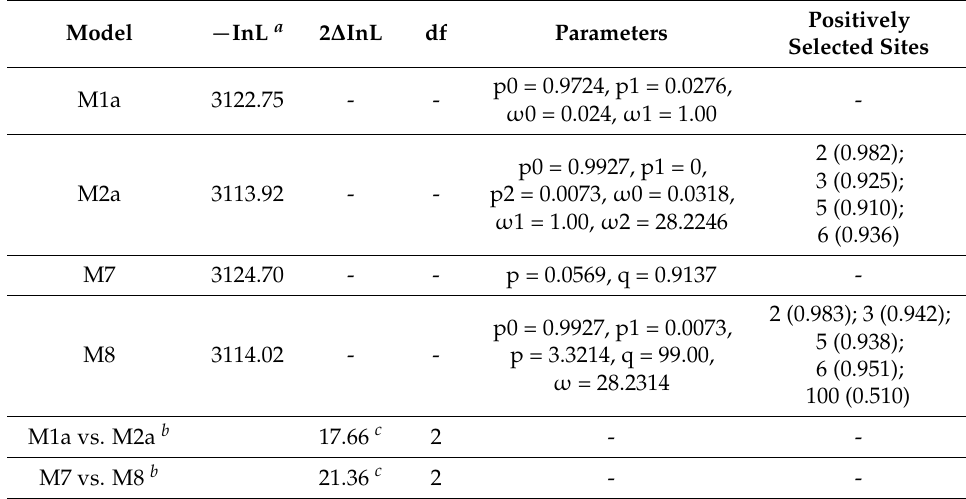
Table 4. Parameters, positively selected sites, and hypothesis test under site